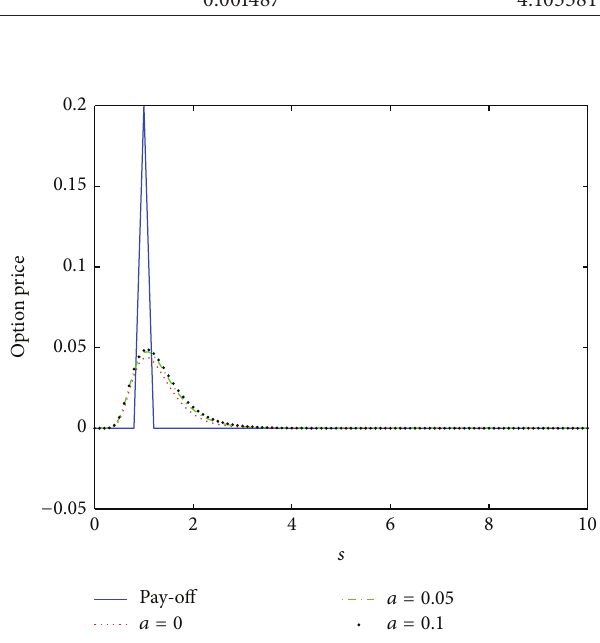
Figure 4: Option pricing of a European butterfly spread for several values of parameter 𝑎 at maturity time 𝑇 = 0.5 , where ℎ = 0.1 and Δ𝑡 = 0.0005 .